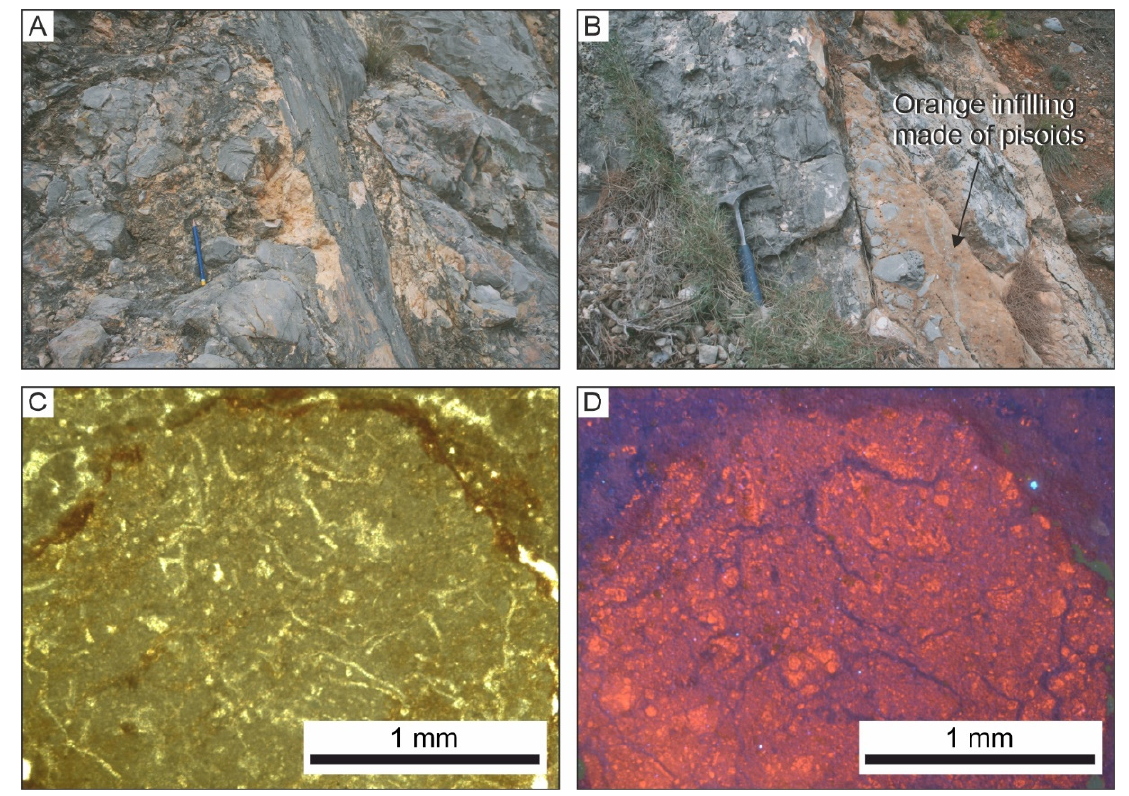
Figure 9. ( A ) Neogene normal fault plane showing a cataclasite formed during the movement of the fault. ( B ) Fractures filled with collapse-breccias and the orange fill made of pisoids (OP1). ( C , D ) Optical (plane polarised light) and cathodoluminescence images of OP1 fill.